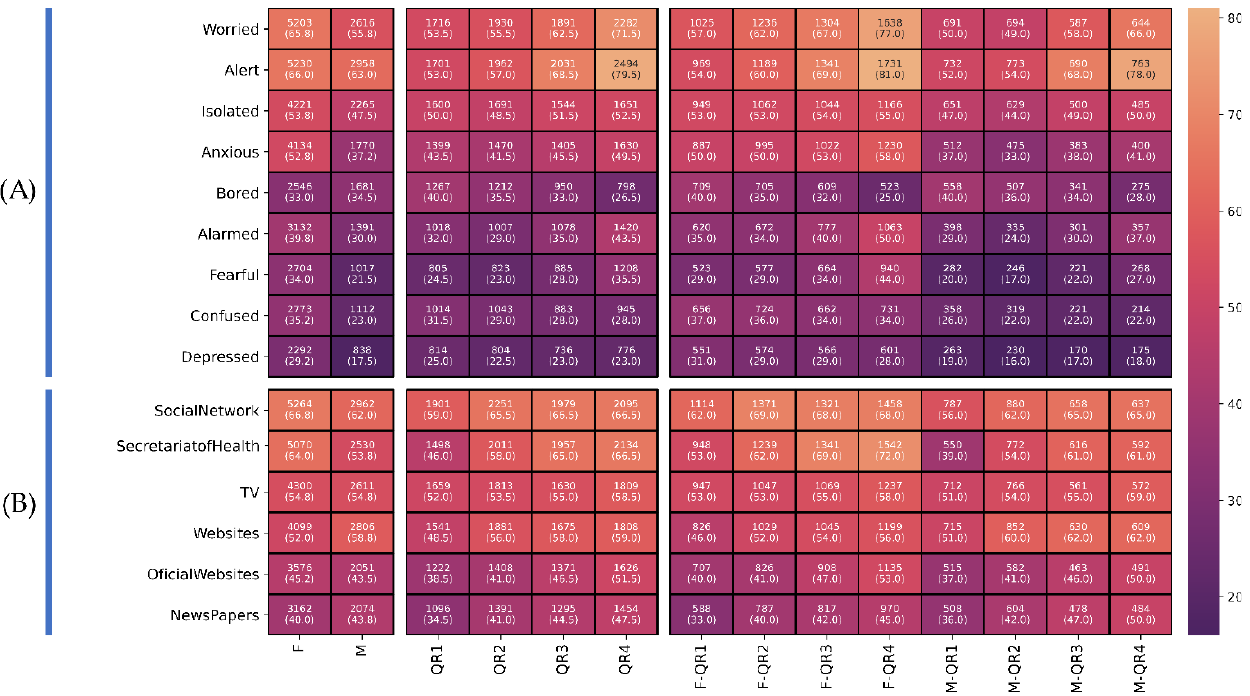
Figure 3. Relation between the perception of risk and gender and the emotions. (3A) reported by the individuals and the media consulted (3B). All groups are reported with a p < 0.01 illustrating the total number of individuals (percentage of the total group). The more intense the colour, the higher the frequency on the scale.